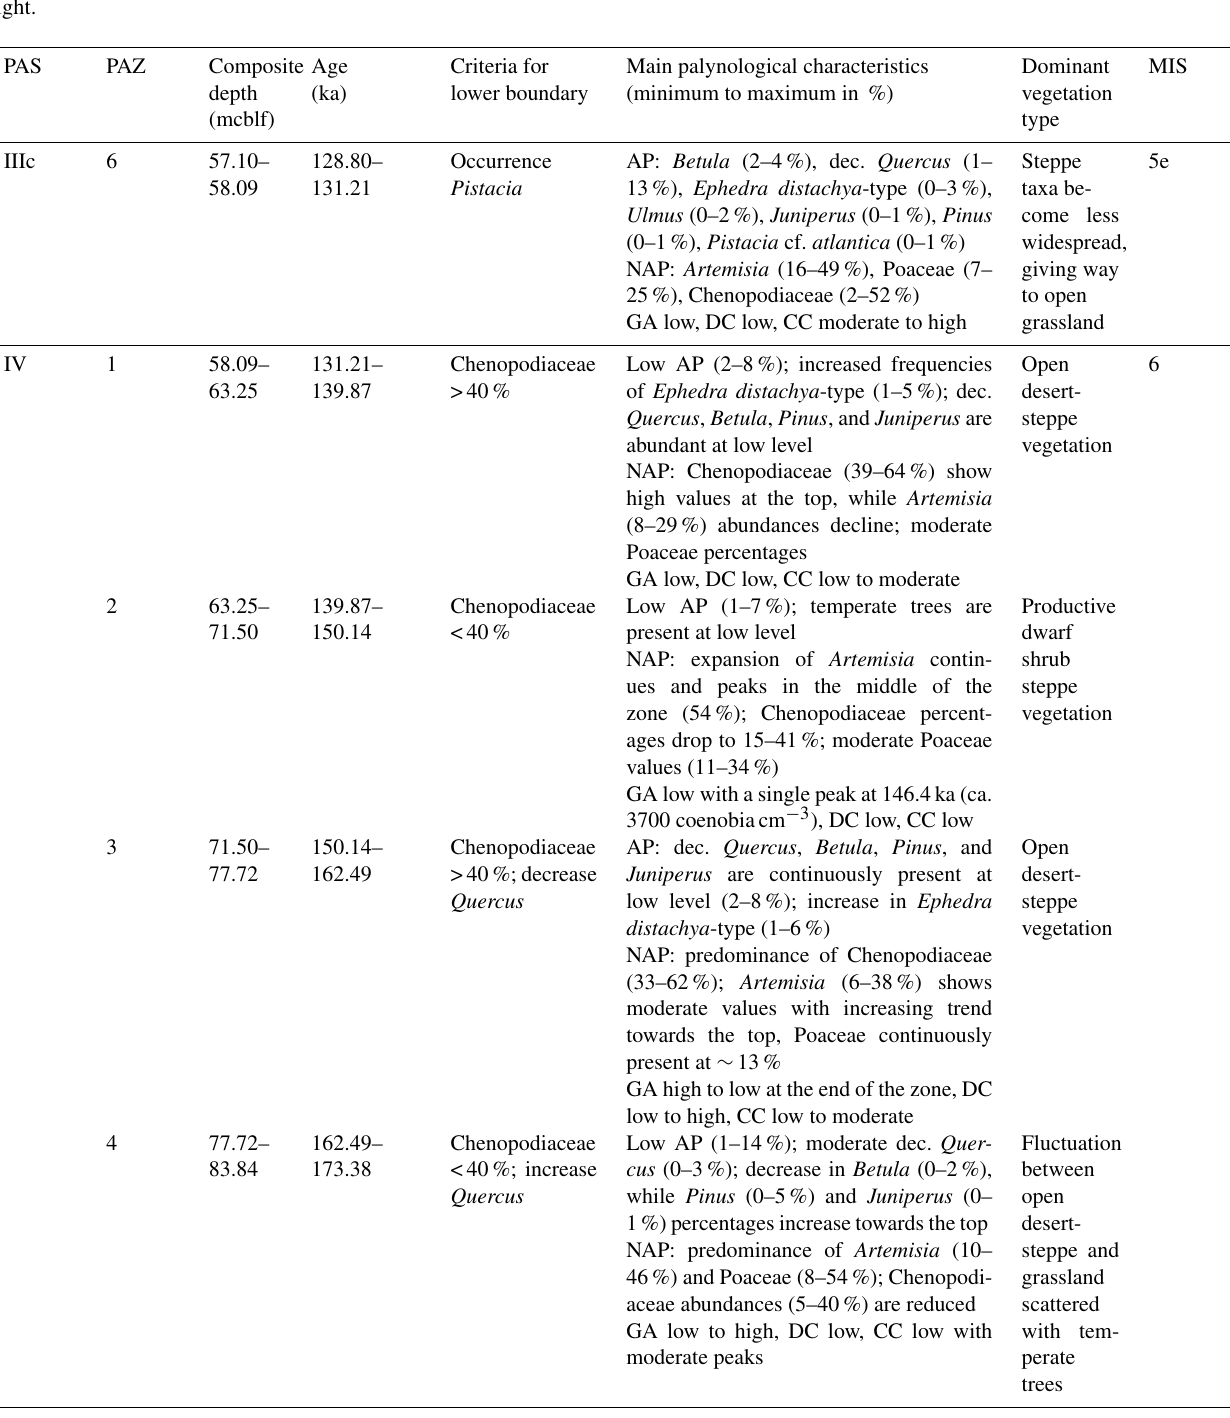
Table 2. Main palynological characteristics of the Lake Van pollen assemblage superzones (PAS) and zones (PAZ) with composite depth (mcblf), age (ka), criteria for the lower boundary, components of the pollen assemblage (AP: arboreal pollen, NAP: non-arboreal pollen), green algae concentration (GA: low <1000; high >1000 coenobiacm − 3 ), dinoflagellate concentrations (DC: low <100; high >100 cystscm − 3 ), charcoal concentrations (CC: low <2000; moderate 2000–4000; high >4000 particlescm − 3 ), and their inferred dominant veg- etation type during the penultimate interglacial–glacial cycle. Marine isotope stages after Lisiecki and Raymo (2004) are shown on the